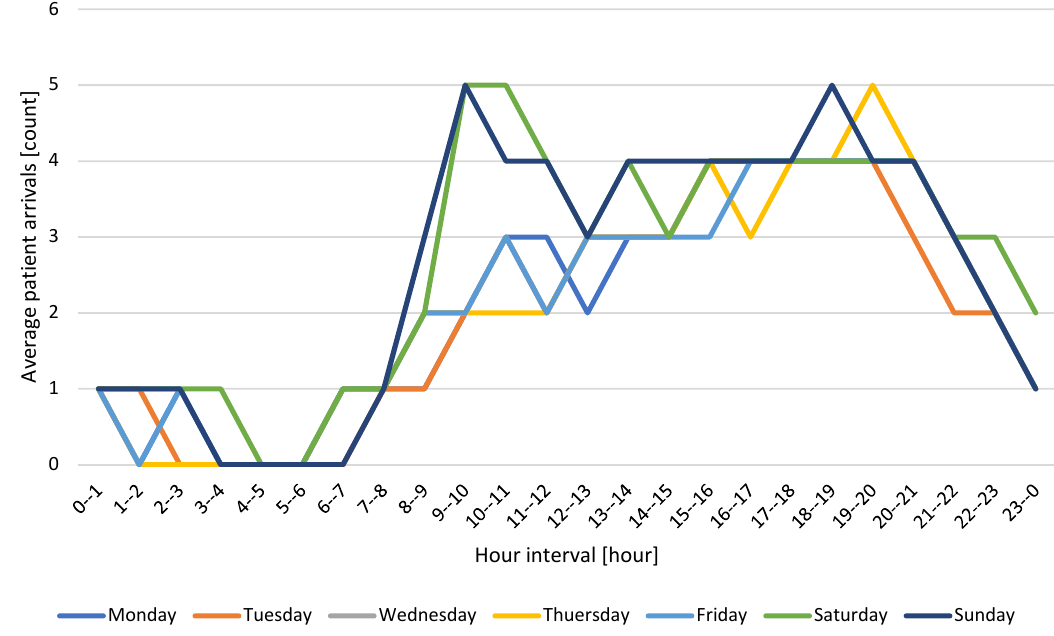
Figure 6. Average daily arrival rates during the week.